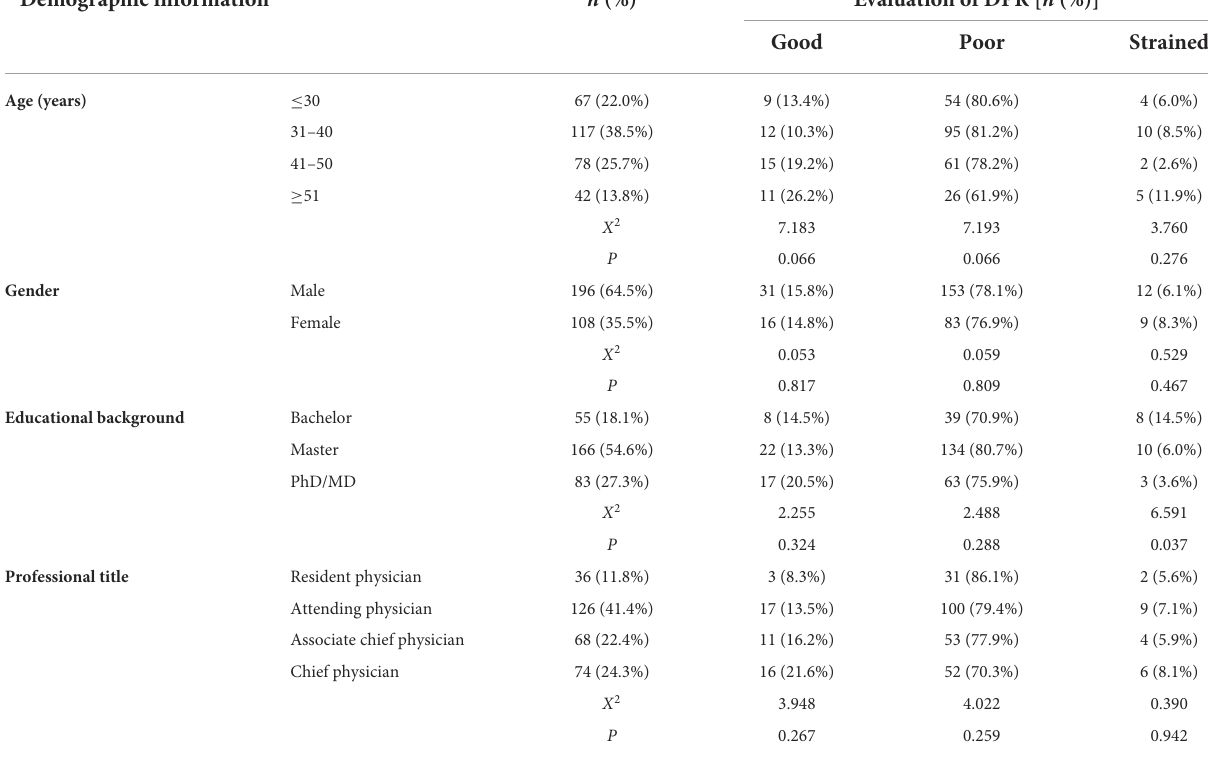
TABLE 3 Physicians’ evaluations of doctor–patient relationship (DPR) under the demographic information.